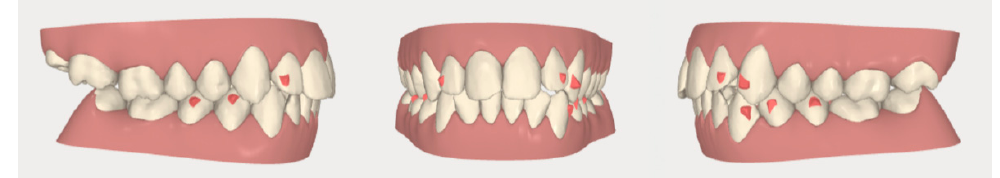
Figure 7. Case 1: initial and final digital frontal and lateral images showing the adopted attachment placement.